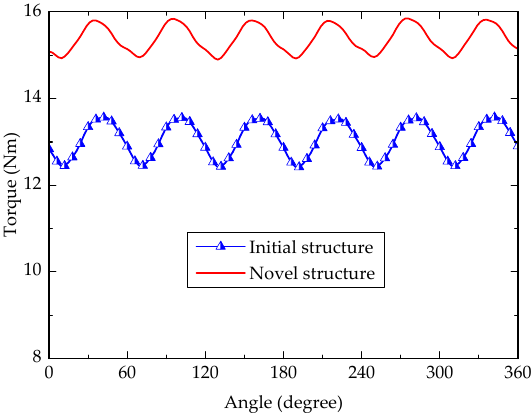
Figure 11. Electromagnetic torque waveforms under J = 5 A/mm 2 .